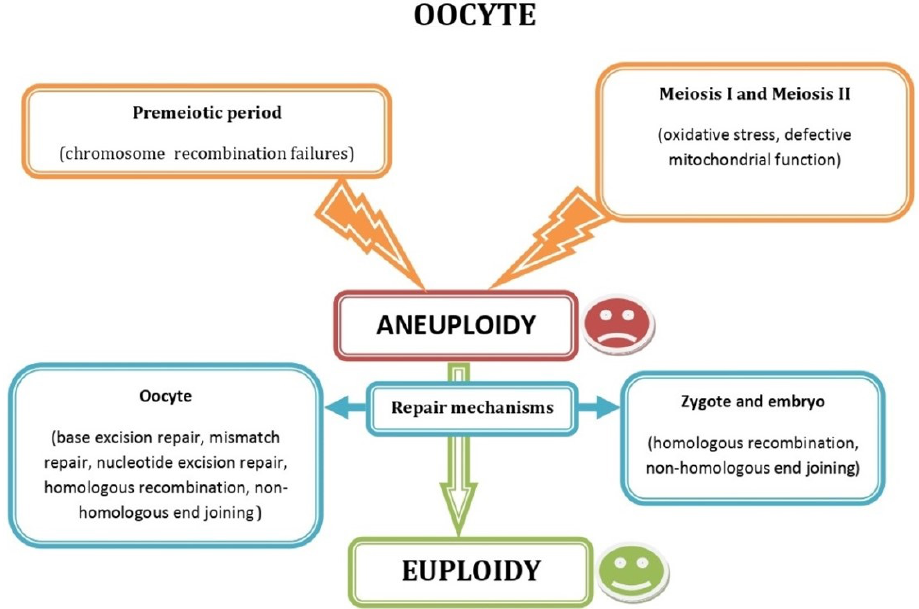
Figure 2. Schematic representation showing the most common factors causing oocyte aneuploidy during the premeiotic and the meiotic period and the DNA repair mechanisms acting in oocytes, zygotes and embryos.